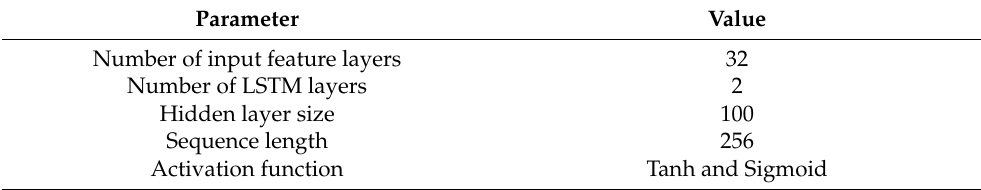
Table 4. Architecture of bi-LSTM model for channel